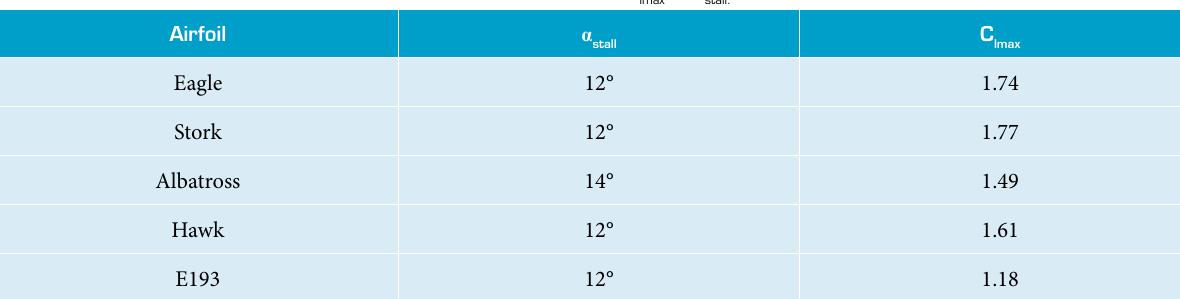
Table 3. Airfoils C